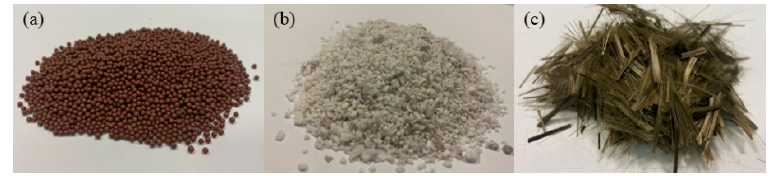
Figure 1. ( a ) Ceramsite; ( b ) glazed hollow beads; ( c ) basalt fiber.